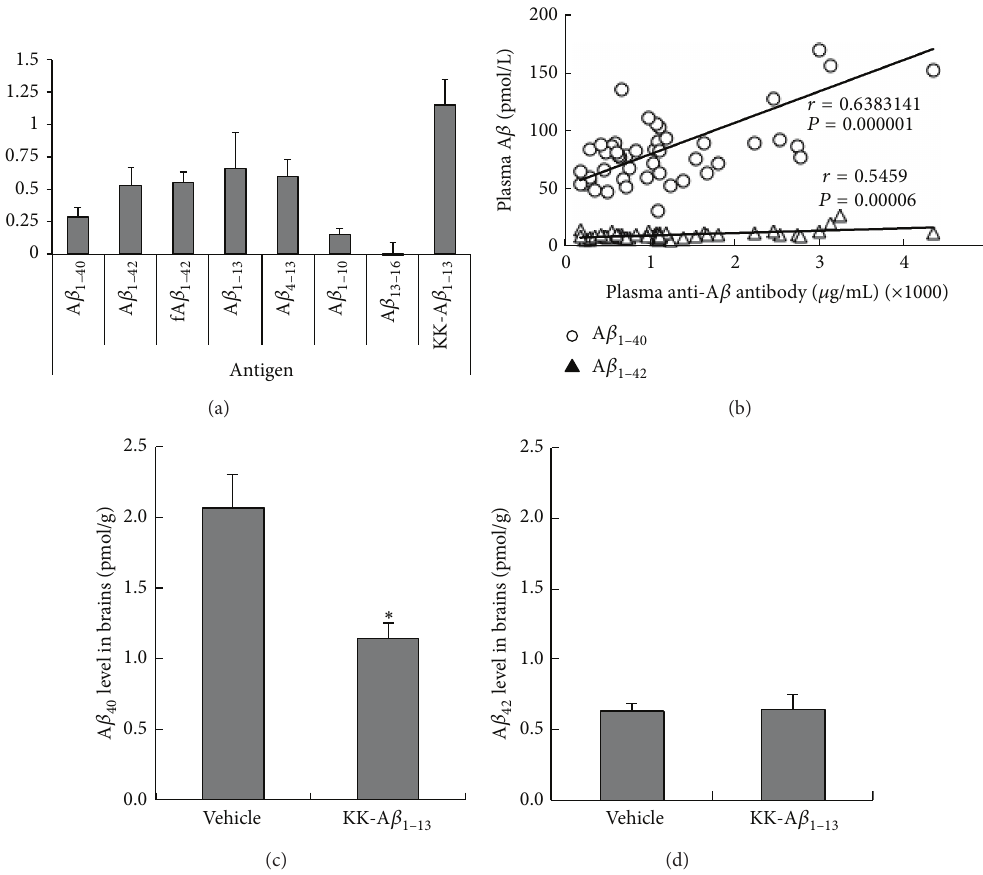
Figure 2: Induction of the anti-A 𝛽 antibodies in the plasma and A 𝛽 peptides in the brain by immunization of the peptide vaccine to guinea pigs. Epitope-mapping of plasma anti-A 𝛽 antibodies immunized with RGD-DiTox 382 of antibodies was performed using each peptide-precoated ELISA with plasma collected at two weeks after the final treatment. Results are represented as mean ± SE. 𝑛 = 5 . The plasma anti-A 𝛽 antibody levels of the guinea pigs treated with RGD-DiTox 20 -KK-A 𝛽 1 the correlation of anti-A 𝛽 antibody concentrations to A 𝛽 40 and A 𝛽 42 peptide doses in the plasma (b). The A 𝛽 peptide levels in the brain of guinea pigs (c and d). Diphtheria and tetanus toxoids (DT, 200 𝜇 L/head, s.c.) were administered to guinea pigs. Three weeks after the DT treatment, vehicle or the peptide (200 𝜇 g/head) was administered at intervals of 3 weeks (arrows; total 6 times). Blood sampling was performed every week after the initial treatment. Results are represented as mean ± SE ( 𝑛 = 5 ). ∗ 𝑃 < 0.05 and ∗∗ 𝑃 < 0.01 as compared to the vehicle control group (the Dunnett test).